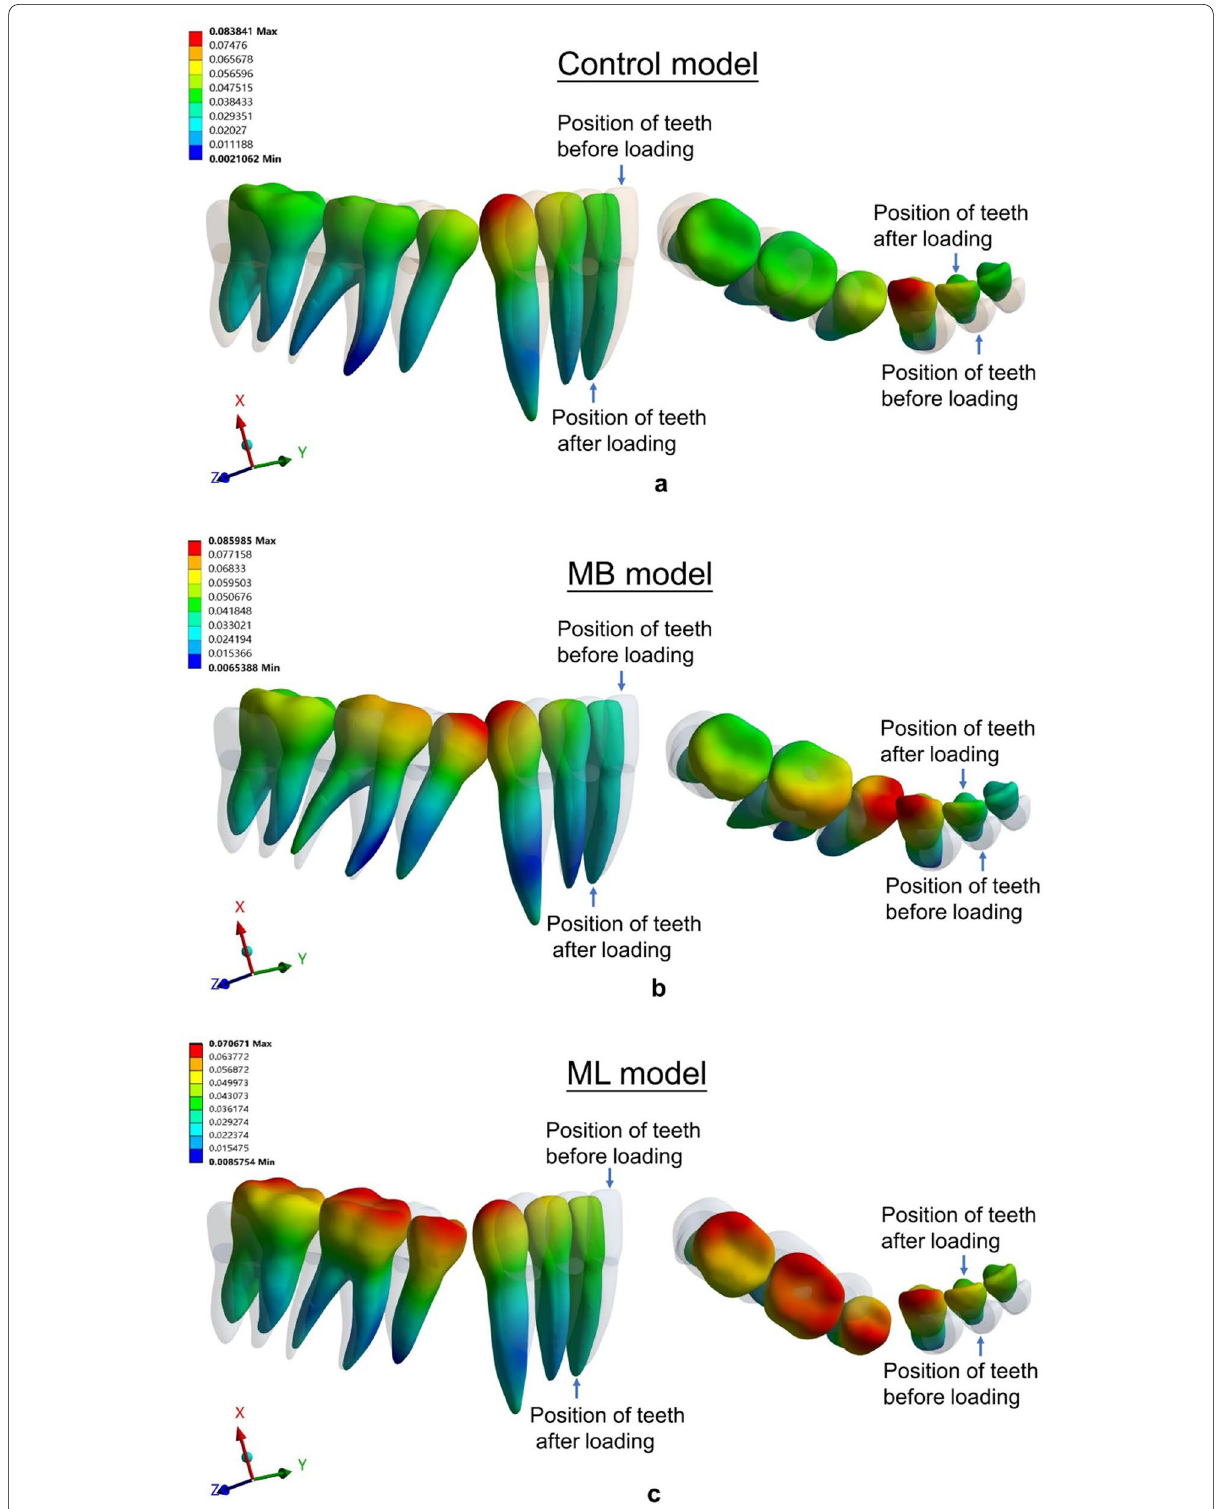
Fig. 7 Displacements (mm) in three models: a the control model, b the MB model, and c the ML model. The gray contour shows the original position. The color image shows the initial displacement (